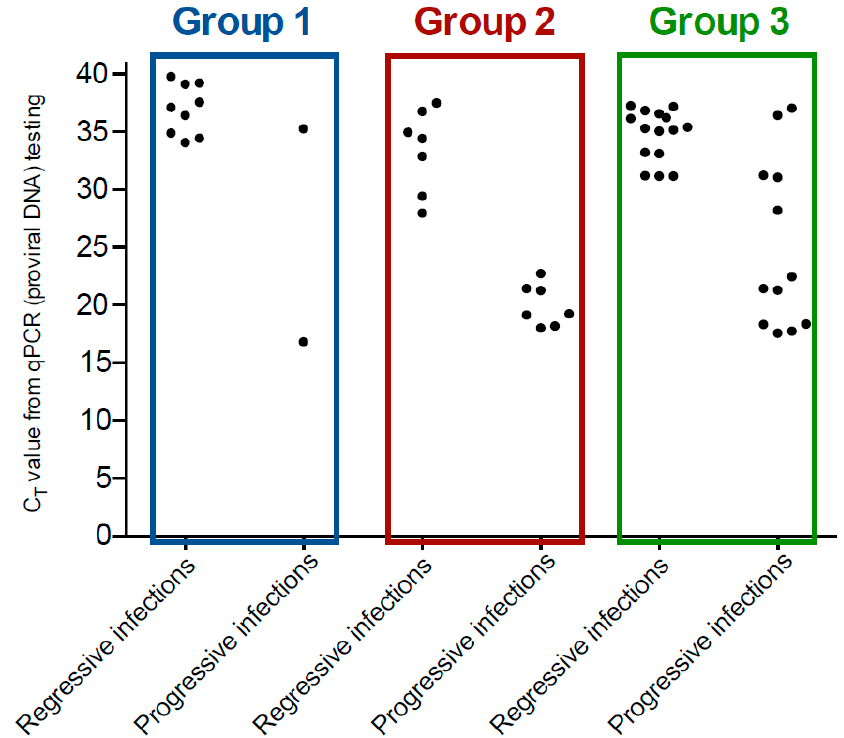
Figure 2. Scatter plot of C T values ( y -axis) from FeLV qPCR testing of EDTA-anticoagulated whole blood samples for the three groups of cats by type of FeLV infection ( x -axis). Samples with a C T value of less than 40 were recorded as a positive result. Presumptively progressively FeLV-infected cats ( n = 21) recorded a significantly lower median qPCR C T value (i.e., higher proviral load) compared to